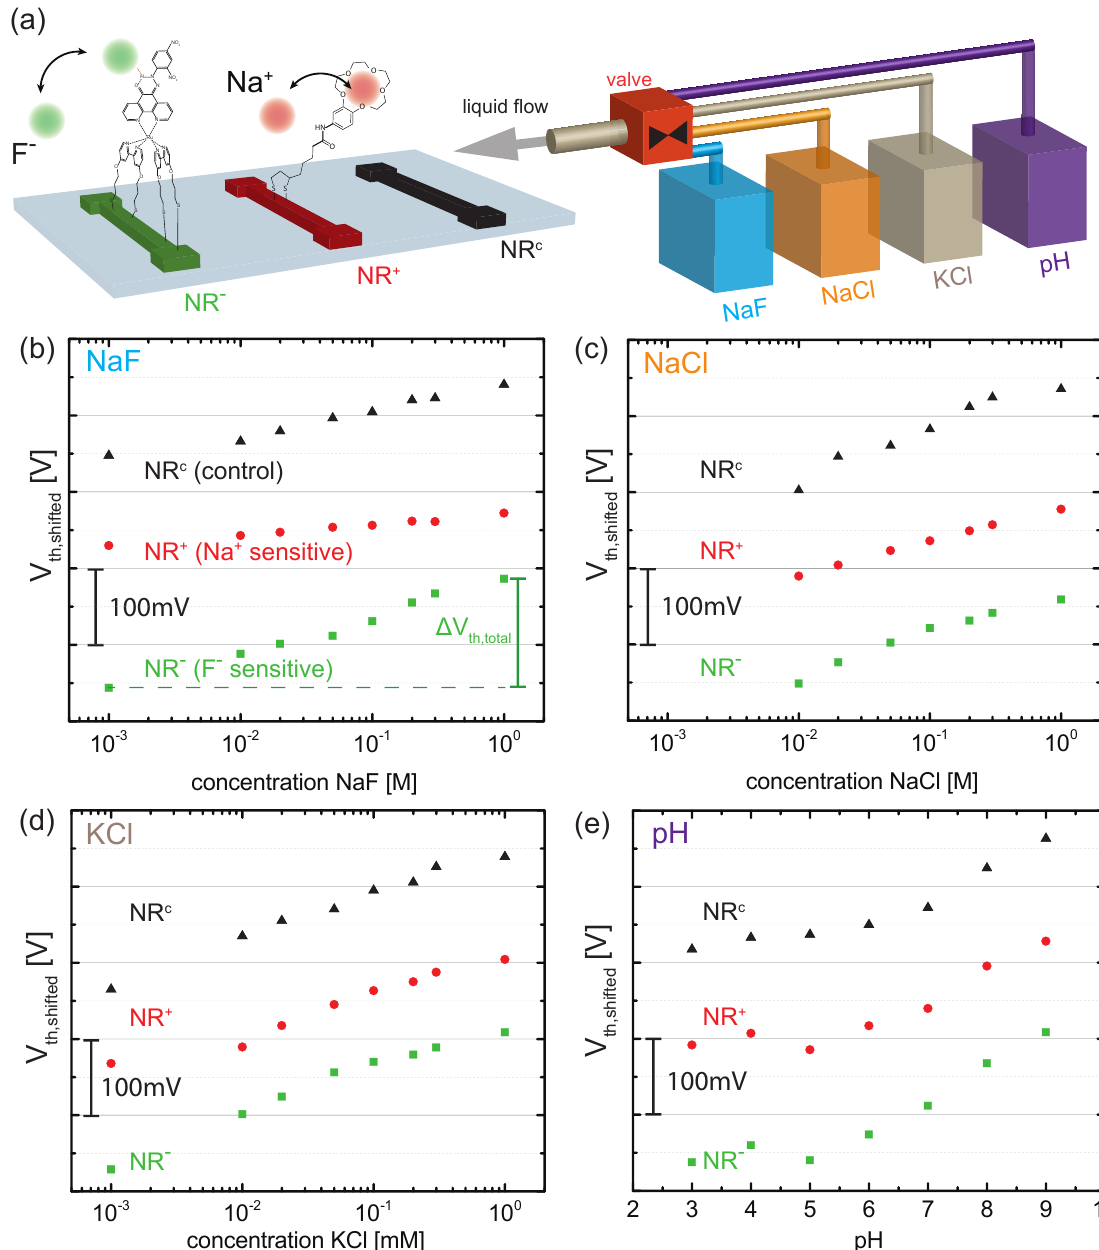
Figure 3. ( a ) schematics of the ion detection experiment. The response of a specific triplet of NRs consisting of an NR functionalized with SAMs of F − ligands (NR − , green ), an NR functionalized with SAMs of Na + ligands (NR + , red ) and an NR with bare gold surface (NR c , black ) is measured in the presence of NaF ( blue ), NaCl ( orange ), KCl ( brown ) and pH ( violet ); ( b – e ) Experimental data (threshold voltage V th versus concentration) for ( b ) NaF, ( c ) NaCl, ( d ) KCl and ( e ) pH. Note that the experimental points of each NR was shifted along the vertical axis leading to V th , shifted . Therefore, the absolute value of V th , shifted have been removed. The total change in threshold voltage ∆ V th , total is defined by the difference of V th ( 1M ) − V th ( 1mM ) as indicated in ( b